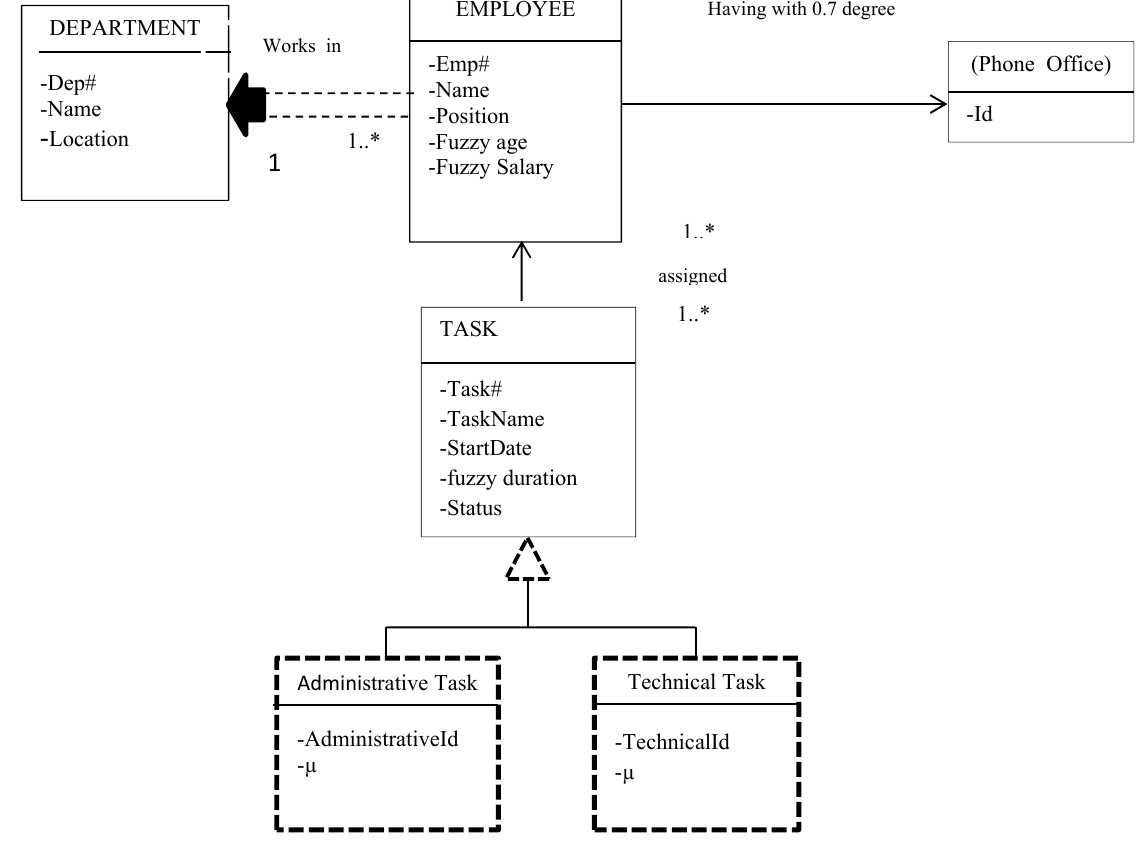
Fig.7. A sample fuzzy object-oriented database